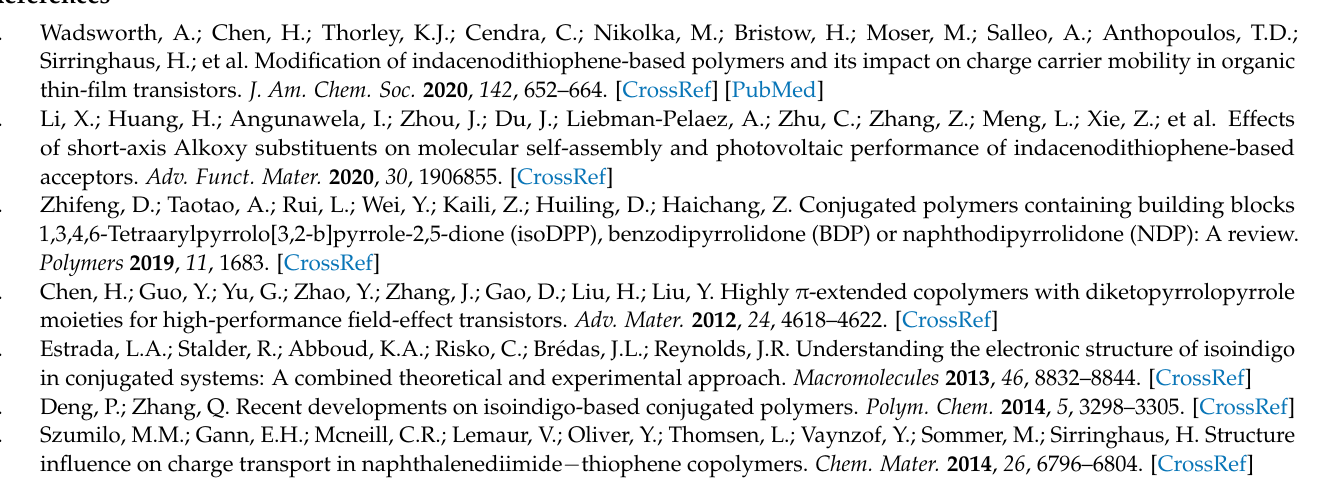
according to mobility, Figure S2: Comparison of transfer characteristics of PFETs at initial state and after 30 days, Figure S3: Temperature dependence of the transfer curves in the linear